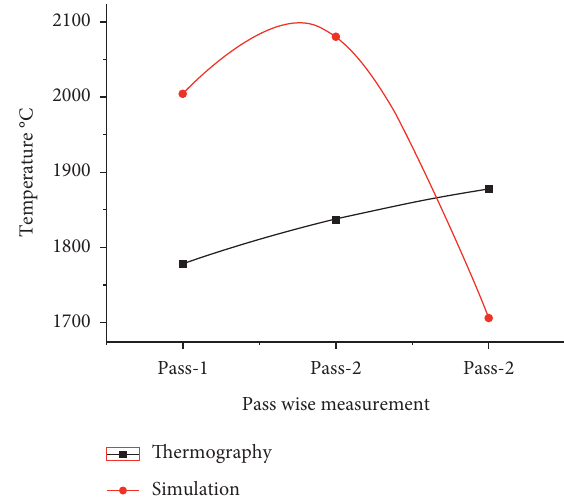
Figure 11: Comparison of thermal